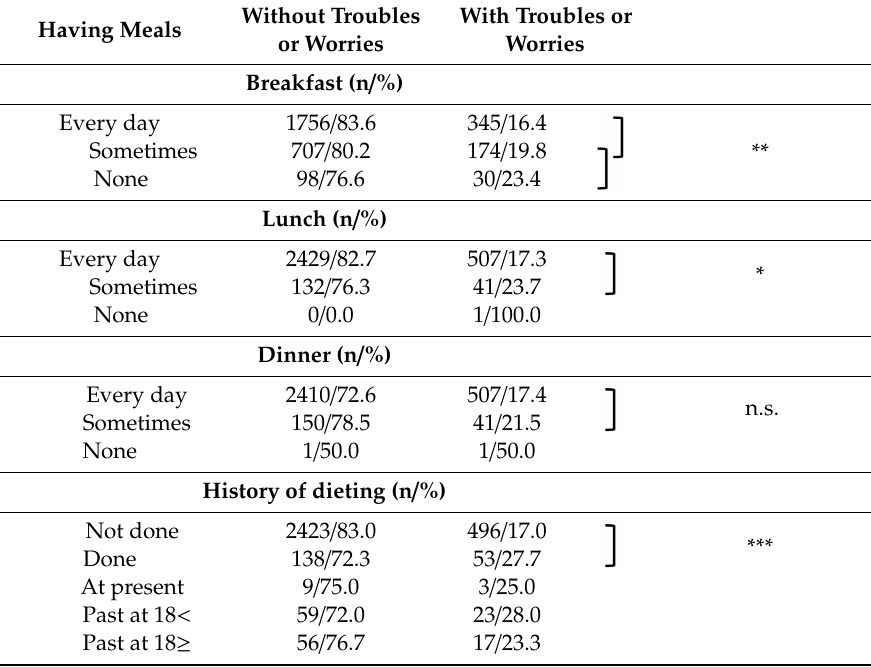
Table 1. Relationship between the incidence of troubles or worries with menstruation and meal skipping or dietary habits.